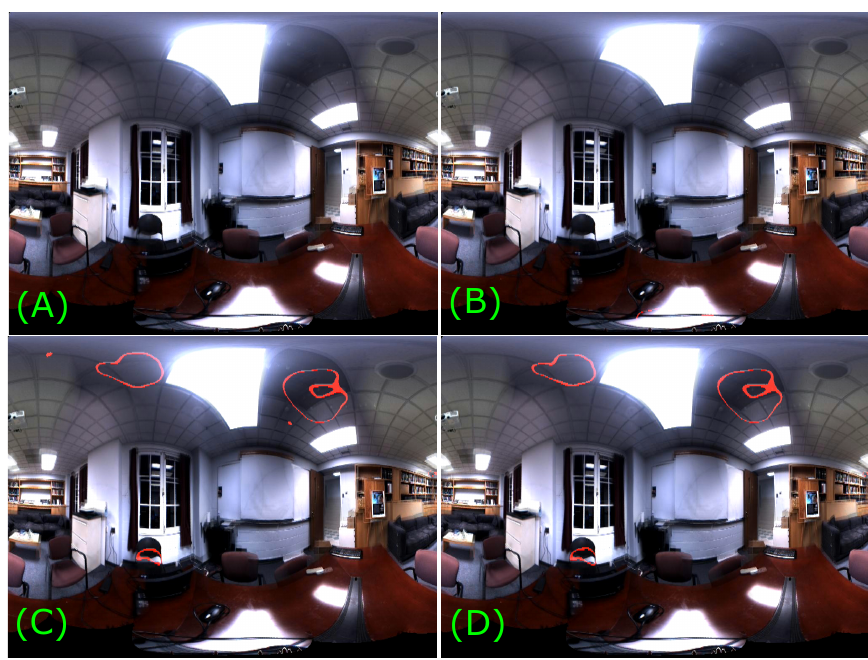
Figure 9. Audiovisual saliency in a static scene. ( A ) Input Frame #173 of Dataset 3. The scene is almost still reducing the visual input to a static image with a weak auditory noise emanating from the air conditioning vent. ( B ) The most salient location according to AVSM 1 coincides with the intensity-based salient location at the bottom of the image. ( C ) AVSM 2 shows some locations that are not salient according to any feature. This may be happening due to exaggeration of auditory reflections, which are detected as salient in AVSM 2 . ( D ) AVSM 3 shows similar results as AVSM 2 .